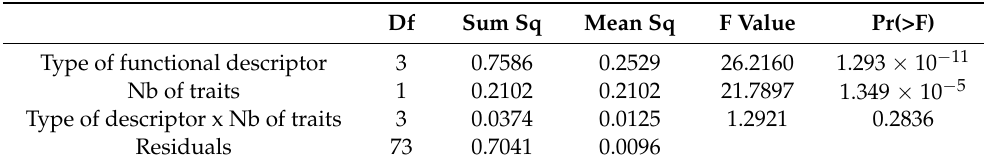
Table 3. Results of the ANOVA performed on the linear model. Adjusted R 2 [acoustic model] ~ type of functional descriptor x Nb of traits.